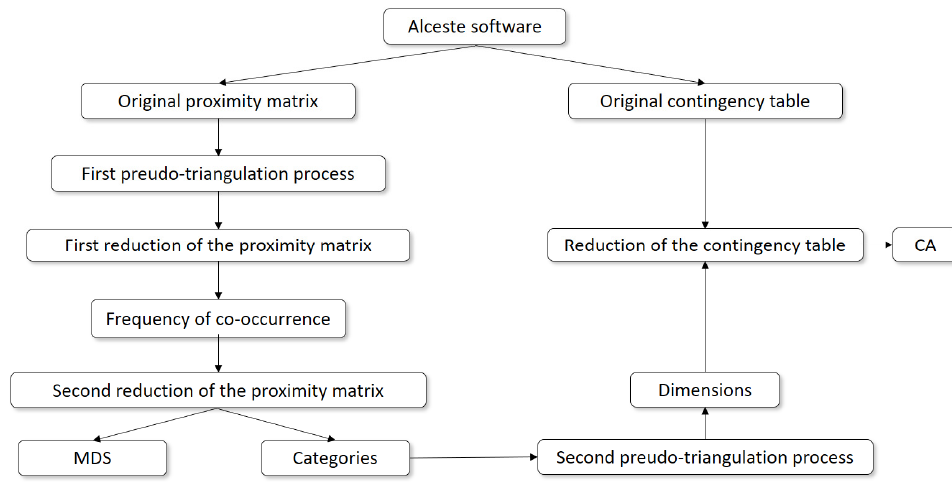
Figure 2. Outline of the steps taken for the identification of the categories and dimensions and their frequencies. CA: correspondence analysis; MDS: multidimensional frequencies. CA: correspondence analysis; MDS: multidimensional scaling.